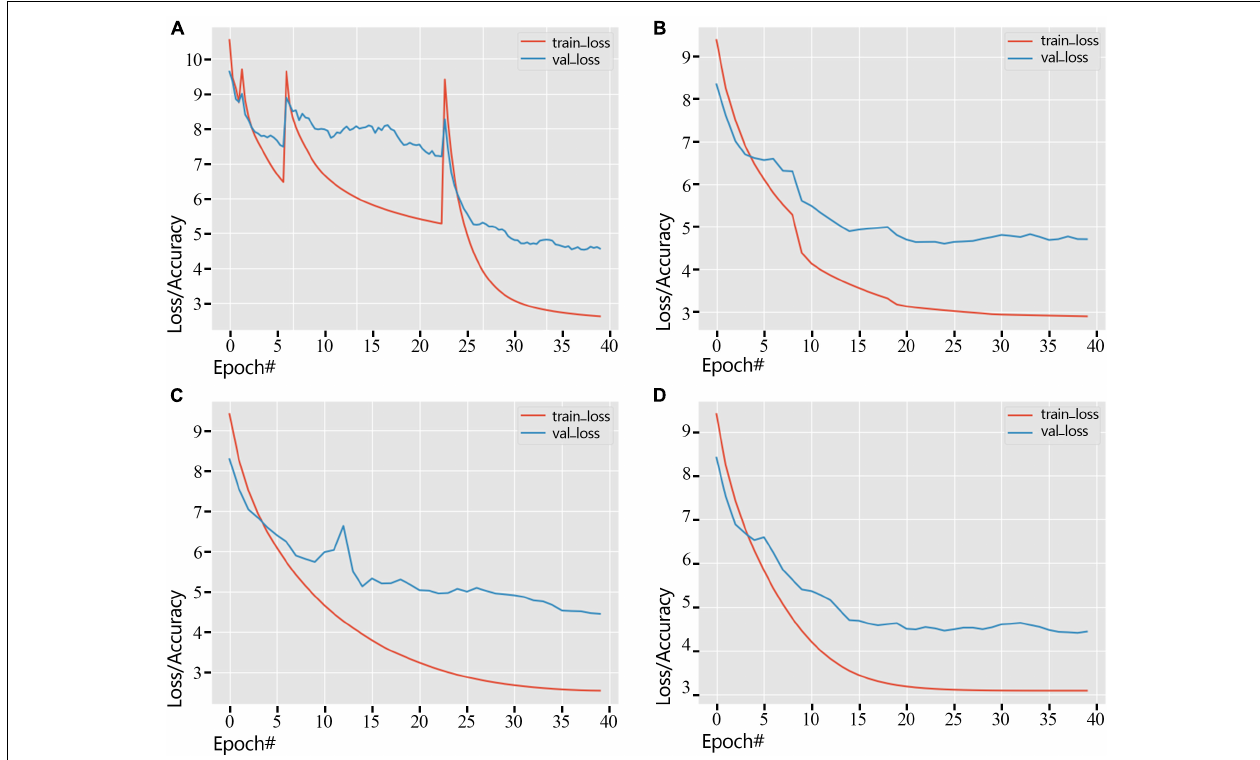
FIGURE 6 | Error variation of training dataset and validation dataset under different strategies (2018 dataset). (A) Standard-decay. (B) Step-decay. (C) Line-decay. (D) Poly-decay.